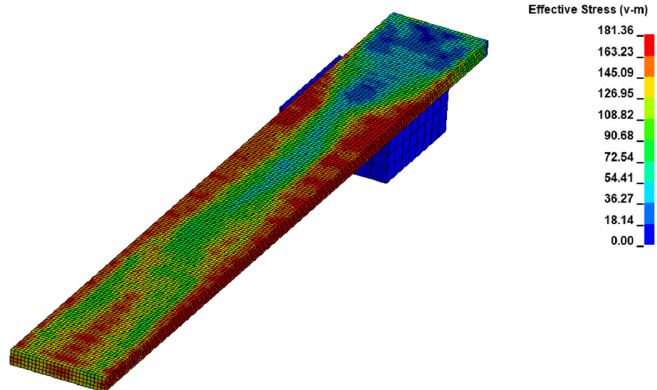
Figure 5. FE-simulated Von Mises Stress stress of the strip.